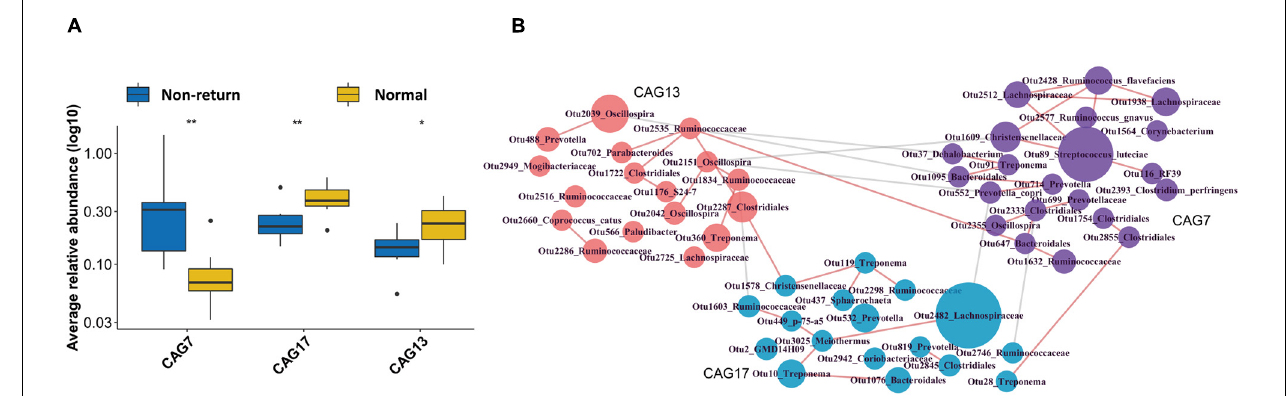
FIGURE 4 | Identification of differential Co-abundance group (CAGs) between normal return and non-return sows. (A) Three CAGs showing different enrichments between normal return and non-return sows. Wilcoxon rank-sum test was used to test the different enrichments, * p ≤ 0.1, ** p ≤ 0.05. (B) The horizontal network diagram of three CAGs showing different abundances between normal return and non-return sows. The diagram shows that the OTUs were enriched between normal return and non-return sows. The name of each OTU node was annotated based on the RDP classifier and the size of the nodes represent the abundance of OTU. The thickness of the connections between nodes indicates the weight of the correlation coefficient between OTUs. Lines were drawn only when its correlation coefficient is greater than 0.2. The red lines represent a positive correlation and the gray lines represent a negative correlation. The colors of the nodes represent different types of CAG.